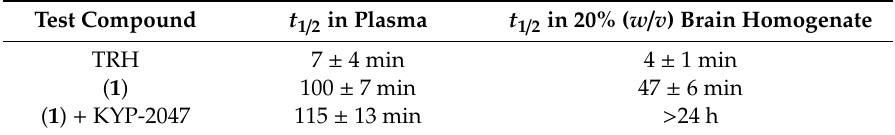
Table 2. In vitro stability in male CD-1 mouse plasma and brain homogenate. Test compounds were used at 10 µ M concentration, while KYP-2047 was used at 50 µ M. Data represent averages, n = 3, indicated errors are standard